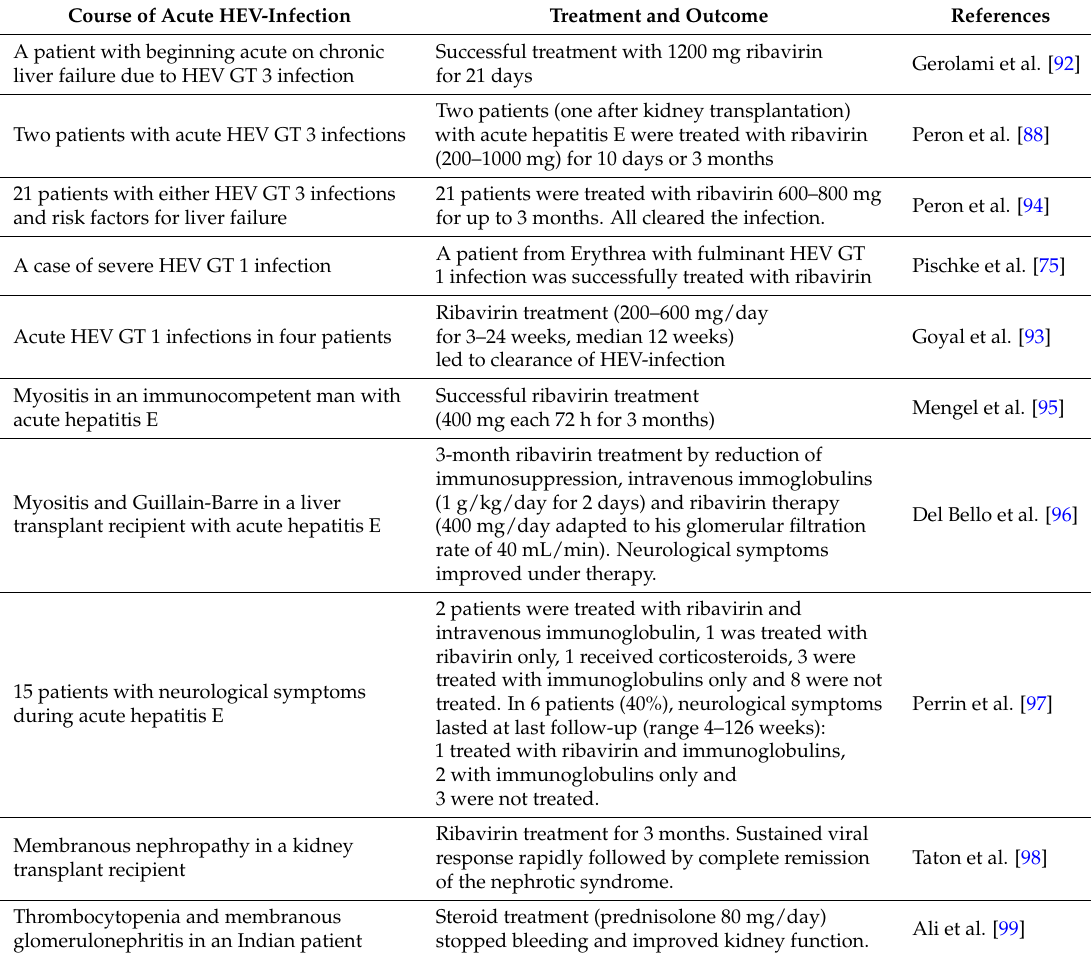
Table 2. Treatment experiences in patients with acute hepatitis E (chronic infections are not